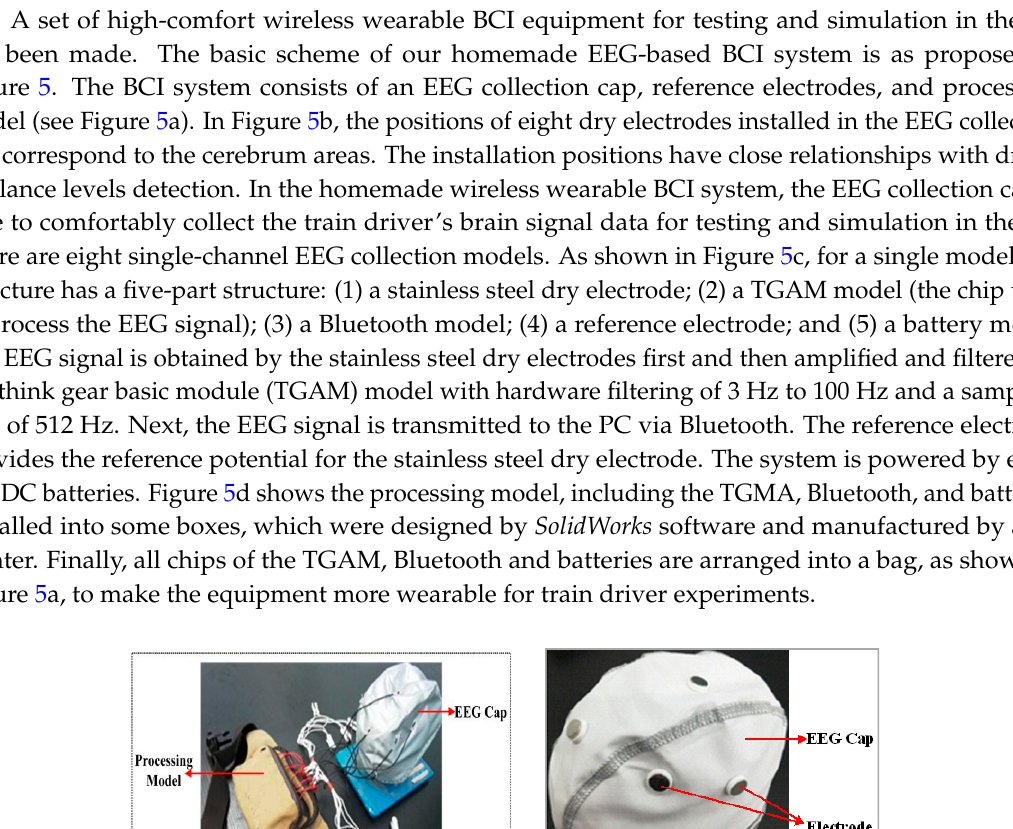
Figure 4. Usage of the BCI system. ( a ) diagram of usage; ( b ) Field usage.